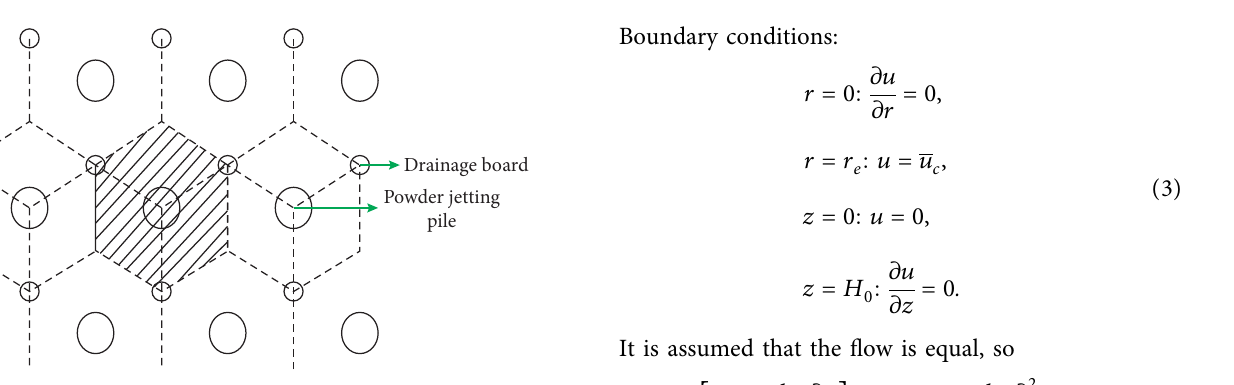
Figure 1: Drainage powder jetting pile floor plan.